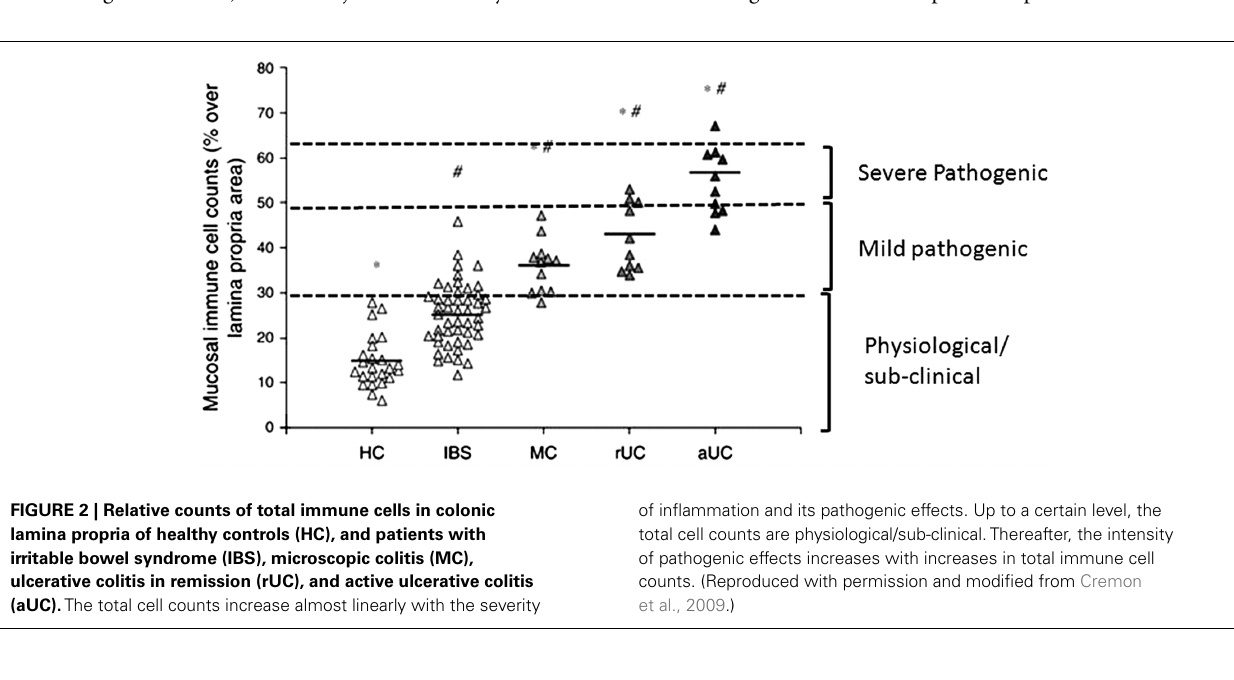
of inflammation and its pathogenic effects. Up to a certain level, the total cell counts are physiological/sub-clinical.Thereafter, the intensity of pathogenic effects increases with increases in total immune cell counts. (Reproduced with permission and modified from Cremon et al.,